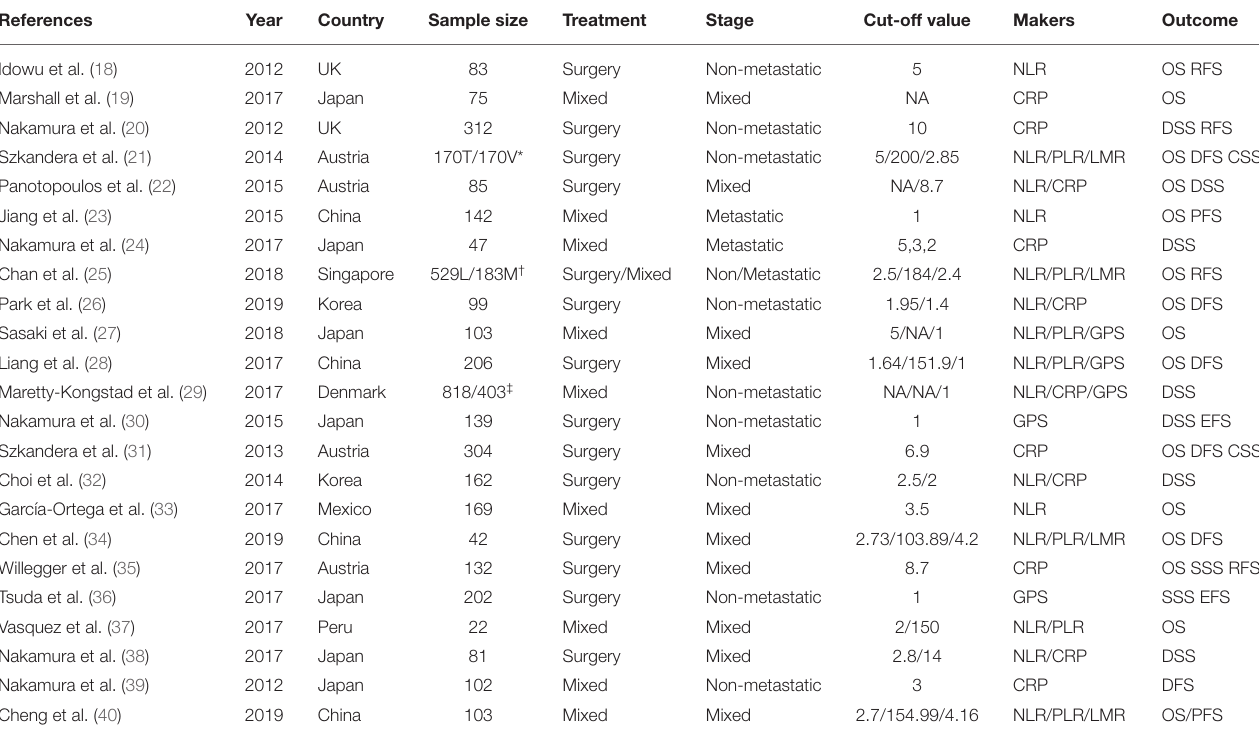
TABLE 1 | Baseline characteristics of studies included in the